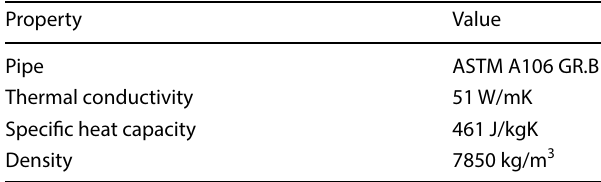
Table 3 Calculated thermophysical properties of Al